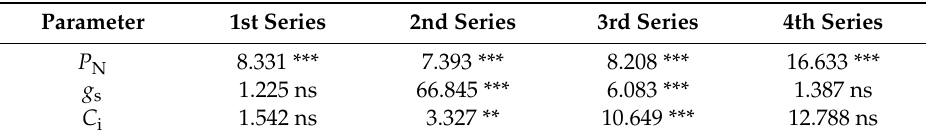
Table 4. Two-way ANOVA results of photosynthetic activity parameters measured before, in the middle, and after exposure in four series and six sites (including control). F statistics of the interaction of site and term of measurement within the series. *** statistically significant at level α ≤ 0.001, ** statistically significant at level α ≤ 0.01, ns—not